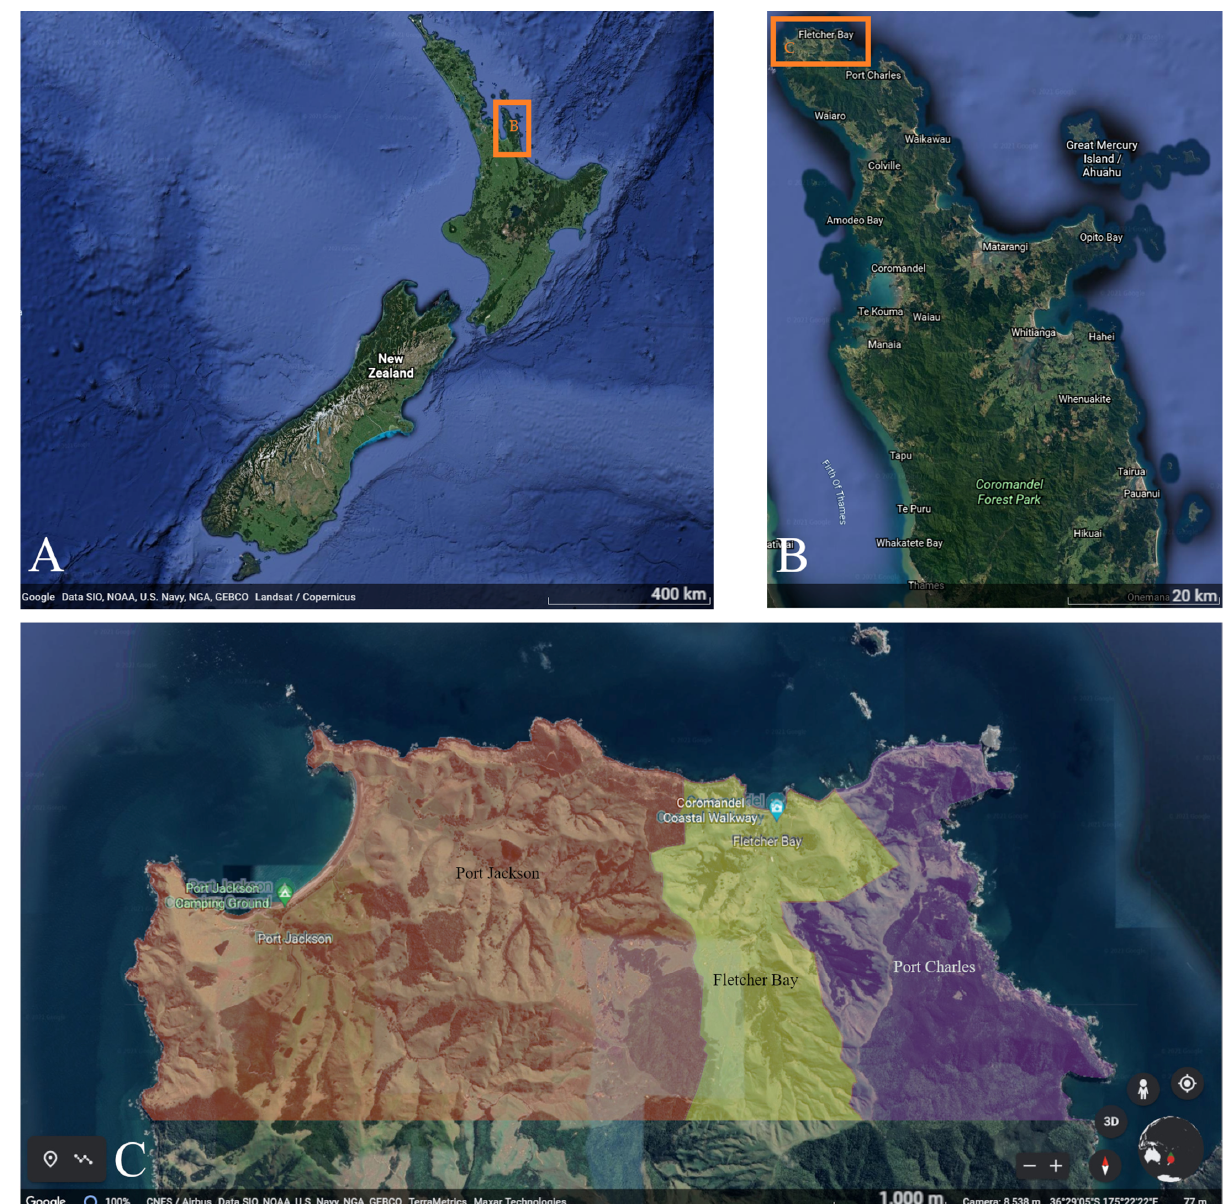
Figure 1. The location of the studied territory. ( A ) New Zealand. ( B ) Coromandel Peninsula. ( C ) The north part of the Coromandel Peninsula: Port Jackson district (orange on the left), Fletcher Bay district (yellow on the center, and Port Charles district (purple on the right) show area of the research. The pictures were taken from Google Earth and the districts from Google maps.